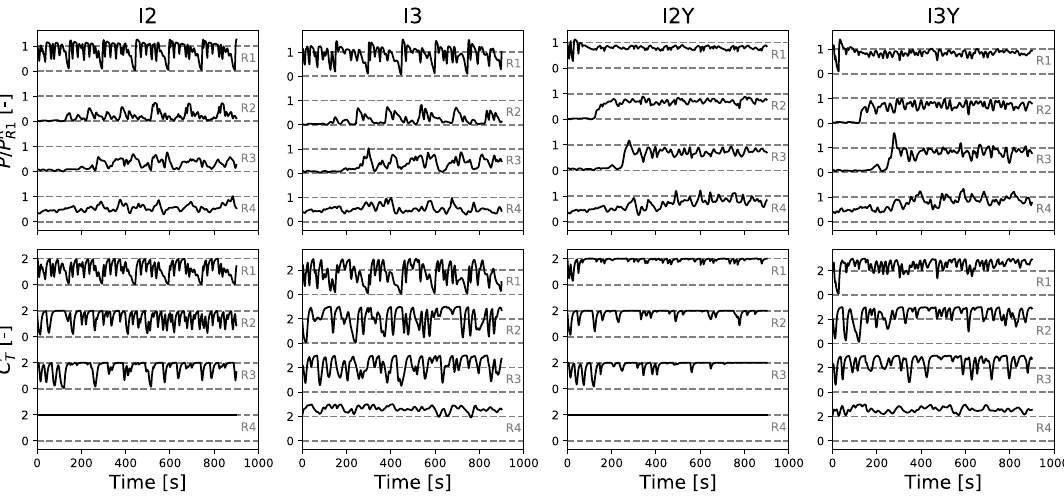
Figure 10. Time evolution of column C1 in uniform inflow induction-enabled cases. Top: Turbine power extraction P , normalized by mean first row power in the uncontrolled reference P Thrust coefficient (cid:98) C (cid:48) T